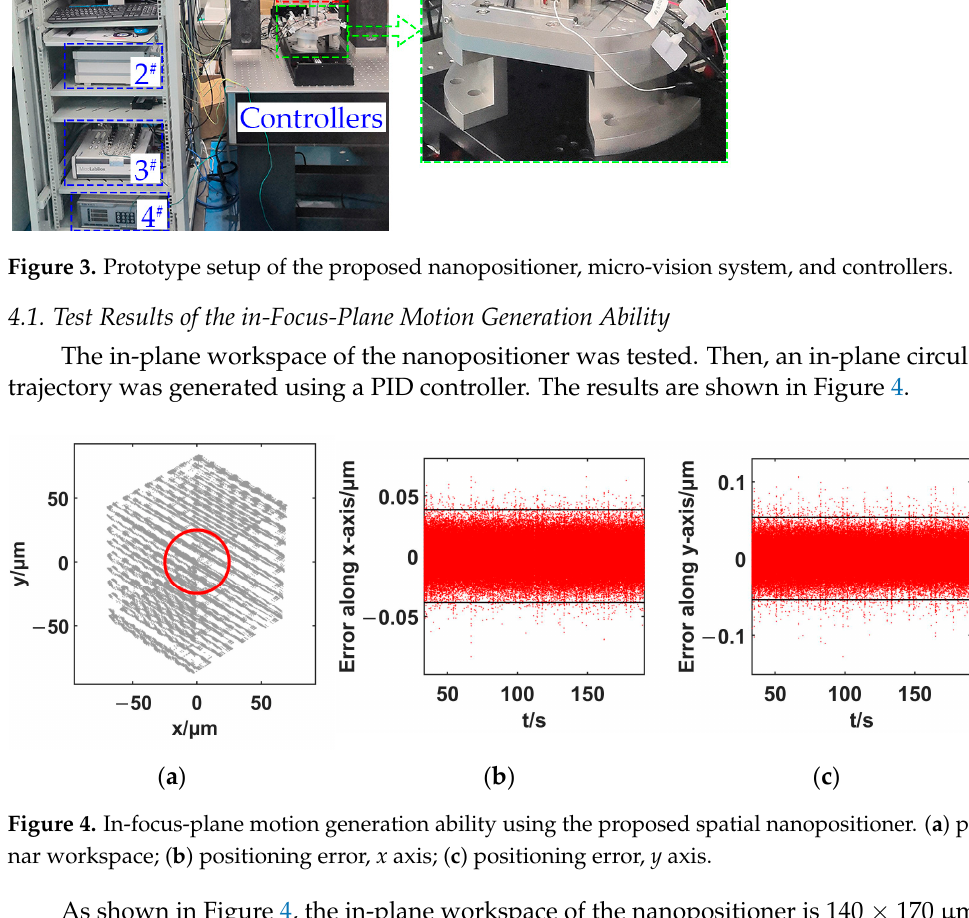
Figure 3. Prototype setup of the proposed nanopositioner, micro-vision system, and controllers.